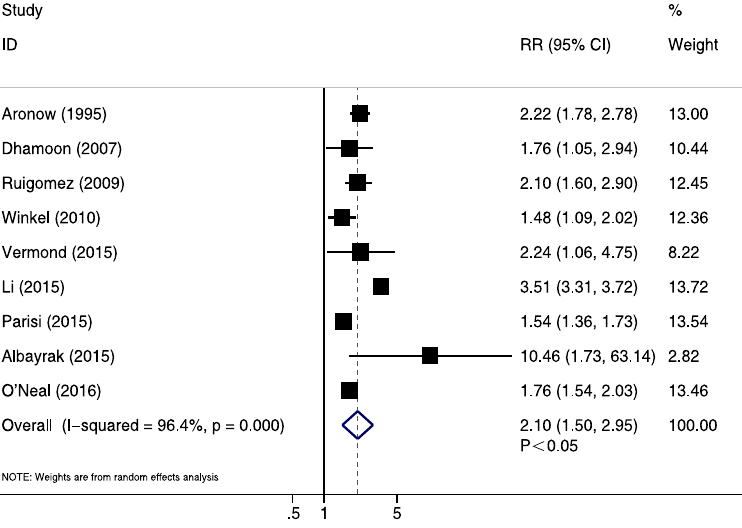
Figure 7. Forest plot showing the comparison between AF and non-AF patients in the pooled analysis of adjusted relative risk for cardiovascular events.